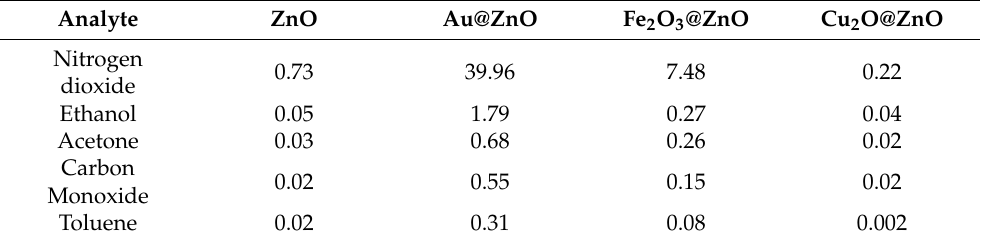
Table 1. Sensitivity ( ∆ R/ ∆ C) in % ppm − 1 to ethanol, acetone, carbon monoxide, and toluene for concentrations between 20 and 80 ppm and nitrogen dioxide for concentrations between 1 and 10 ppm.